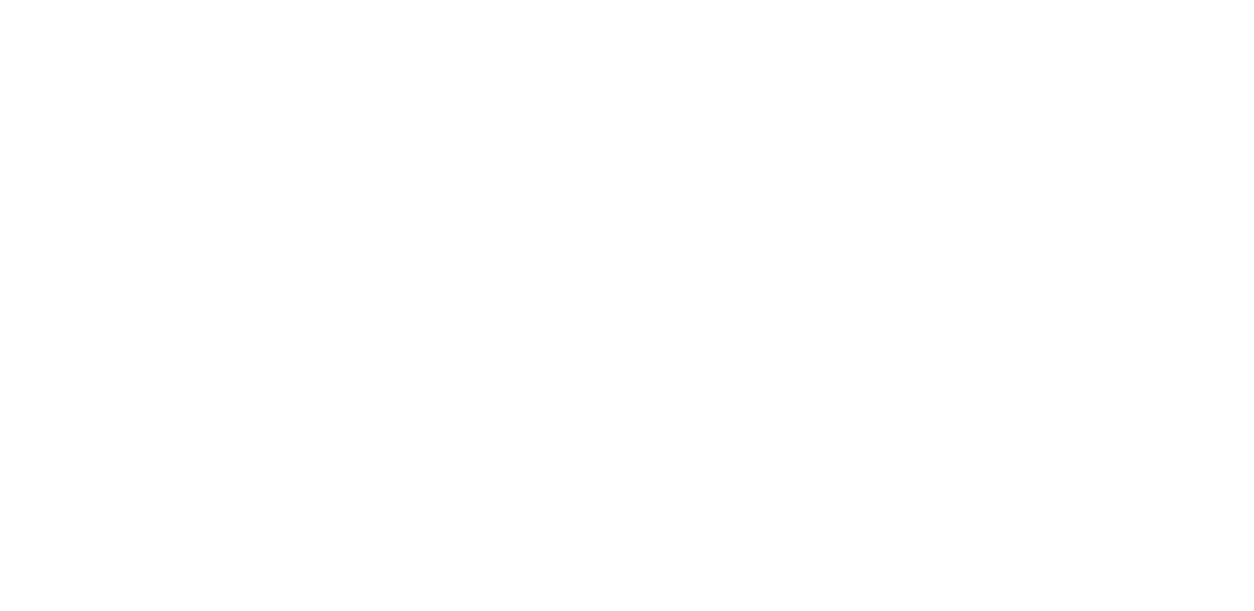
(c) EH plot of S-3. (d) EH plot of S-4. Figure 13. Error-histogram (EH) views of LMA-TNN for Case 2 in Vogel’s